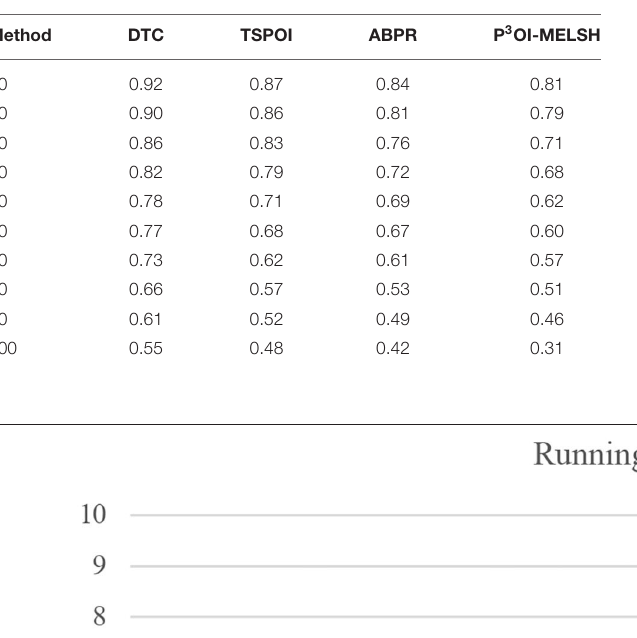
TABLE 3 | MAE comparison with different methods.